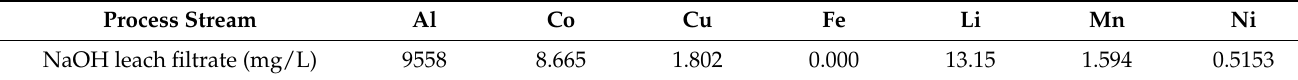
Table 5. NaOH leach filtrate metal composition.